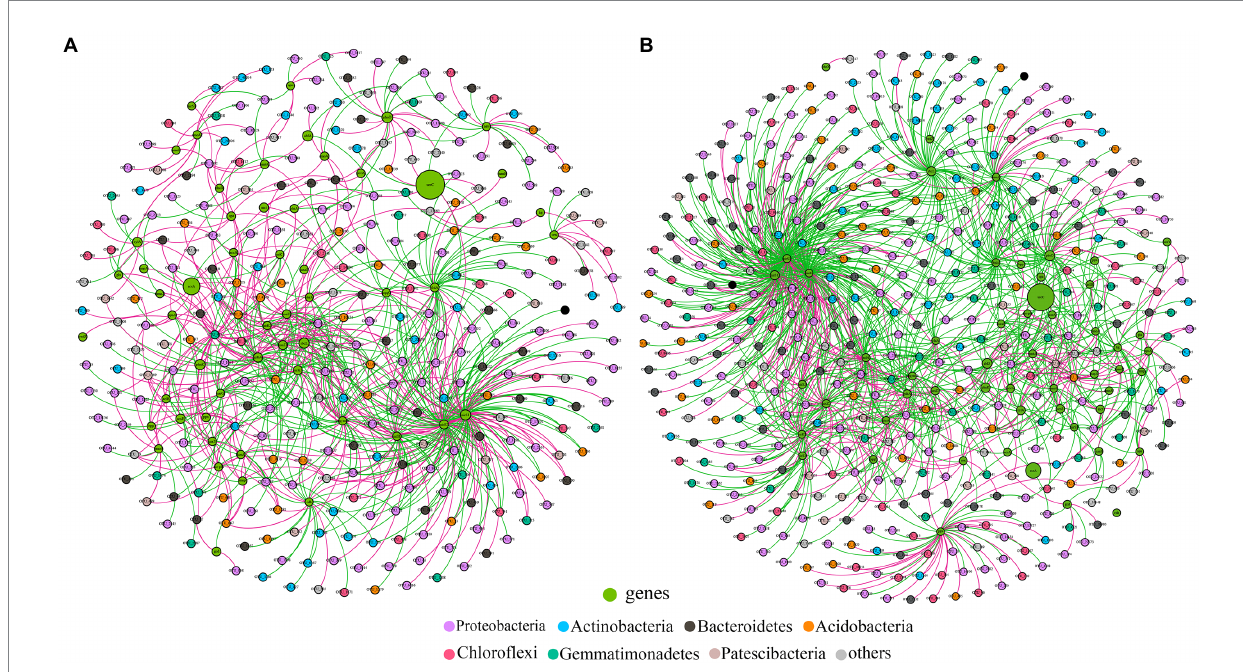
FIGURE 5 Functional molecular ecological networks between functional genes and bacterial OTUs in A . palmeri (A) and native (B) rhizosphere soils. The OTU nodes are colored according to taxonomy at the phylum level. Nodes in green are functional genes. Node size is proportional to its abundance. The red and green edges indicate the positive and negative correlations,